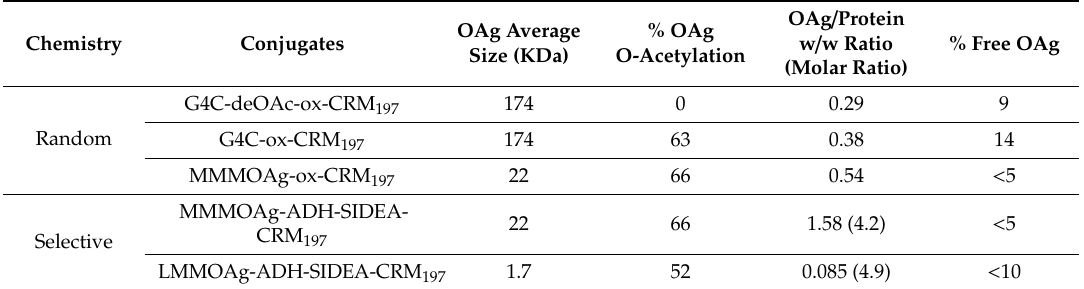
Figure 4. HPLC–SEC fluorescence emission profiles of G4C-ox-CRM 197 ( A ), MMMOAg-ox-CRM 197 and MMMOAg-ADH-SIDEA-CRM 197 ( B ), and LMMOAg-ADH-SIDEA-CRM 197 ( C ) compared to unconjugated CRM 197 . Table 4. Main characteristics of conjugates obtained with sugars of different lengths and by different chemistry.